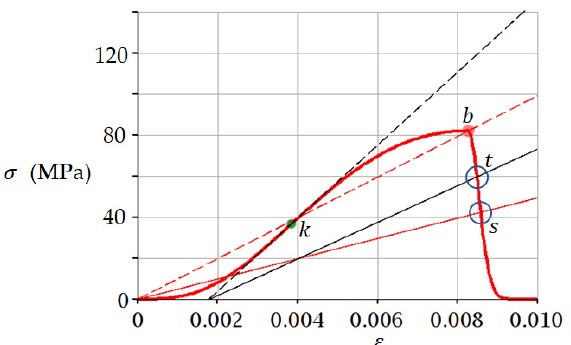
Figure 6. The stress–strain curve (5) for sandstone in uniaxial compression. A tangent (black dashed line) passes through point k , the slope angle of which determines the tangential modulus of elasticity. At point t , we predict failure according to criterion (12), at this point the line σ = 0.5 ε E tangential intersects the curve (5) (see also Figure 5). A secant (red dotted line) passes through point b , the slope angle of which determines the secant modulus of elasticity. At point s the failure is predicted by criterion (14), at this point the line σ = 0.5 ε E secant intersects the curve (5). The red curve simulates the experimental curve from [36]. The thin red and black lines correspond to Figure 5.